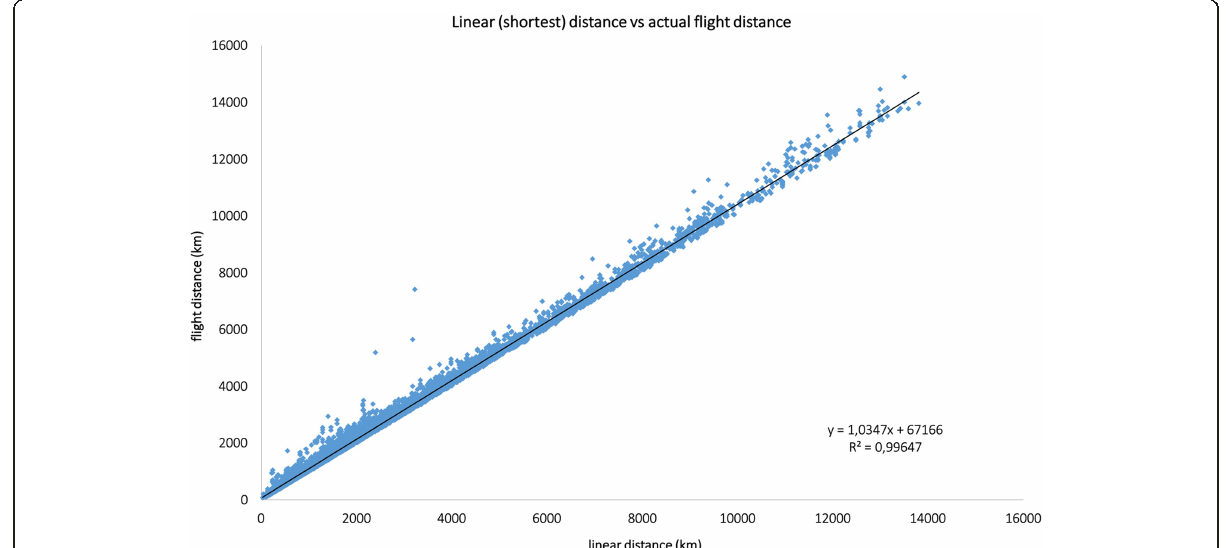
Fig. 1 Flights with distances longer than 24 h (or with other analytical errors) were fitted to an estimated linear curve based on available data from 28,659